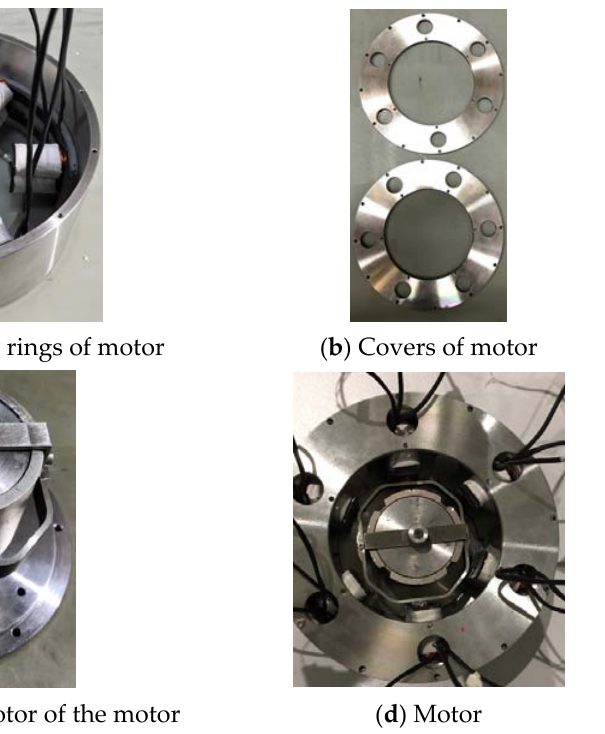
Figure 15. Mechanical parts of motor: ( a ) the housing and the separator rings of motor; ( b ) the covers of the motor; ( c ) the moving parts with the rotor of the motor; ( d ) the motor.